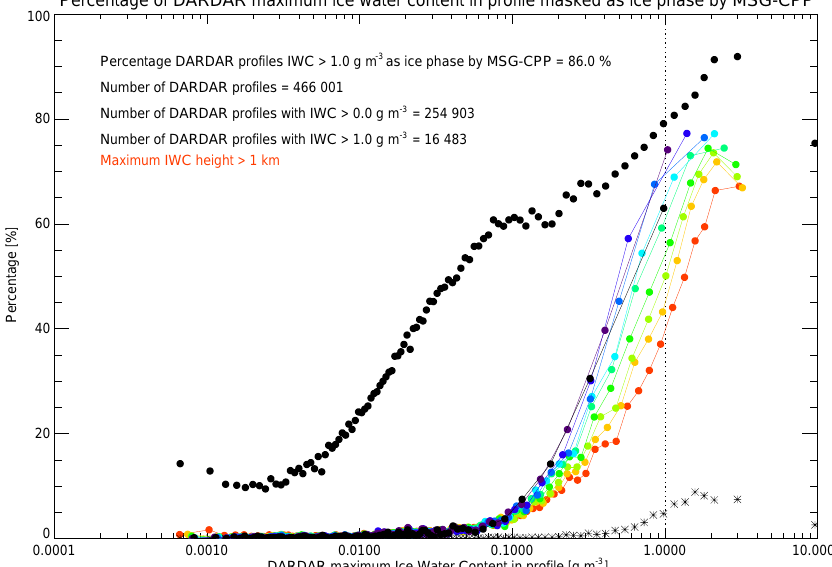
Figure 4. Similar to Fig. 1 (asterisks, high IWC mask v1) but for high IWC mask v2. The black dots indicate the number of MSG-CPP cloud identified as ice given the maximum IWC within the DARDAR profile. The colored lines indicate the percentage of MSG-CPP pixels that qualify for the high IWC mask v2 pixels for DARDAR profiles with the height of the maximum IWC above the given altitude. See the main document for a description of the corresponding MSG-CPP parameter